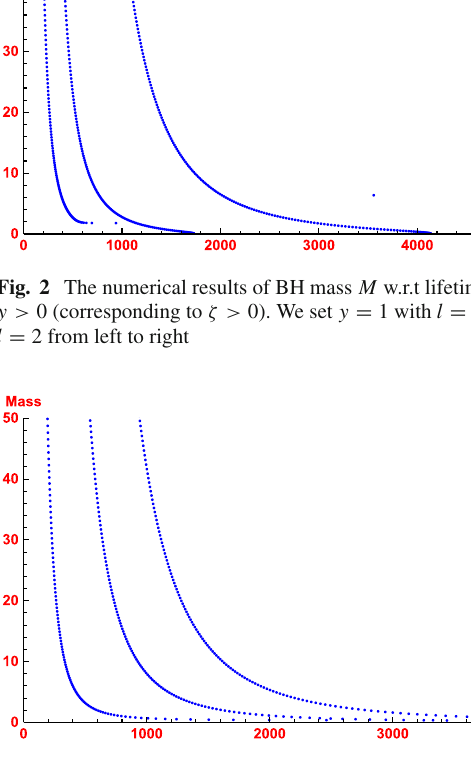
Fig. 3 The numerical results of BH mass M w.r.t lifetime t by setting y < 0 (corresponding to ζ < 0). We set y = − 1 with l = 1, l = 1 . 5 and l = 2 from left to